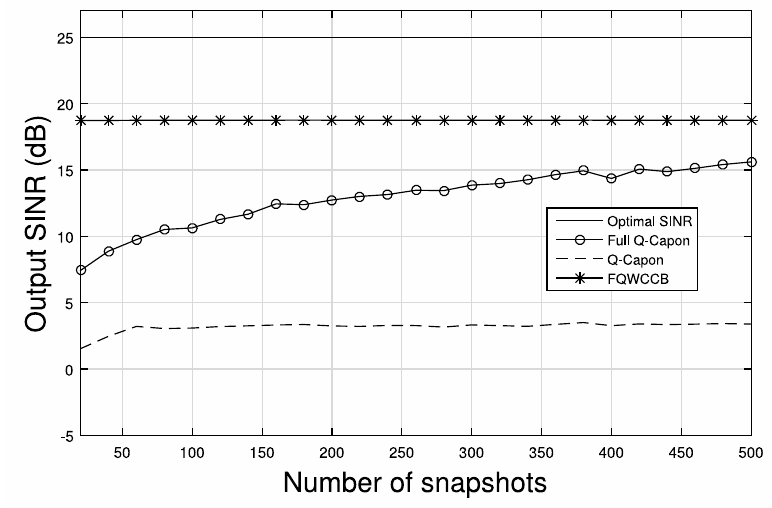
Figure 9. Output SINR versus snapshot number with SNR = SIR = 15 dB and 5 ◦